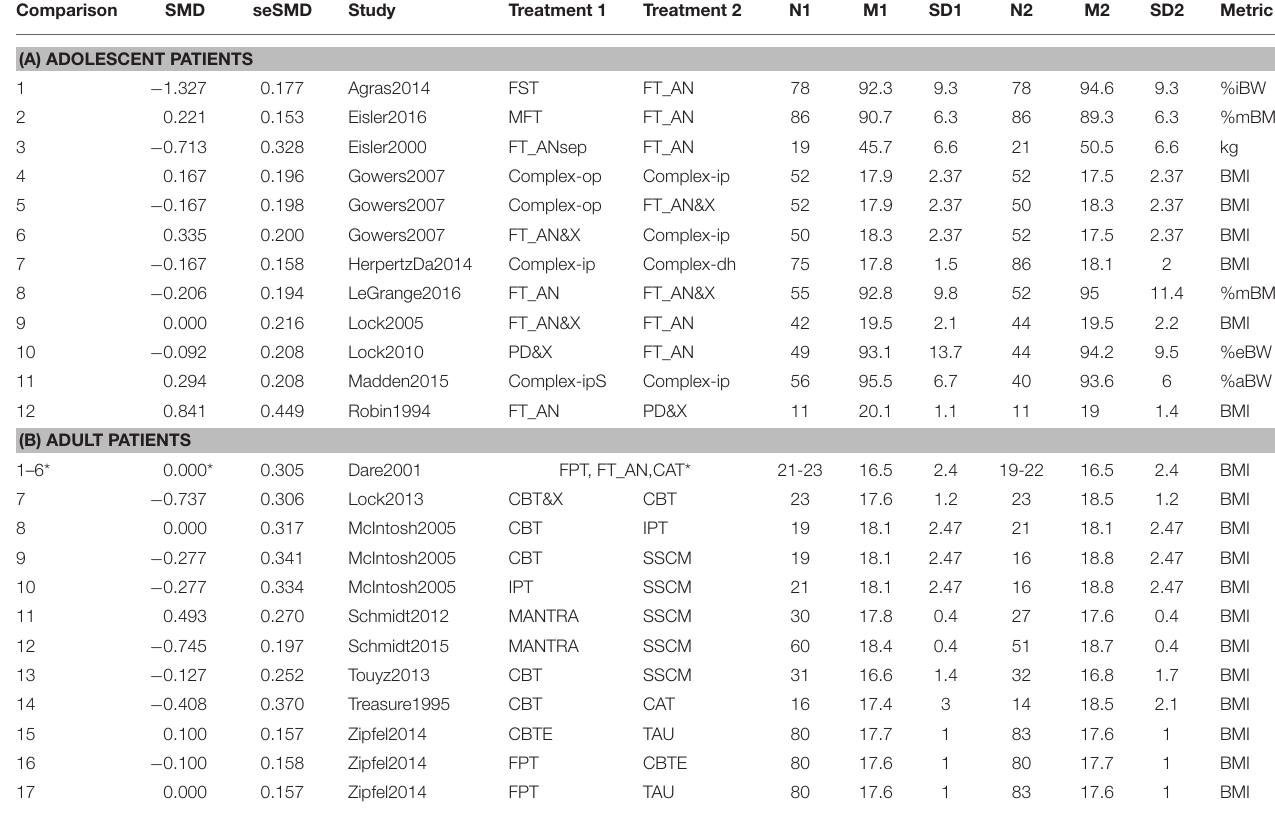
For abbreviations of types of treatment see Table 1 ; * Dare2011 reported the grand mean only as the groups did not differ significantly. Therefore we report only one SMC for all six comparisons of the study; SMD, Standarized Mean Difference; seSMD, standard error; study, ID of main publication; N1, N2, respective sample sizes; descriptive statistics of